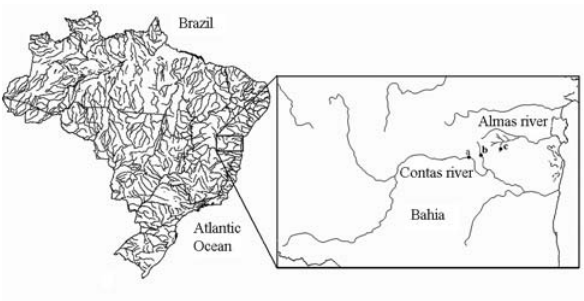
Figure 1 - Hydrographic map of Brazil showing in detail the main rivers for the Contas and Recôncavo Sul basins (State of Bahia) and collection sites of this study: (a) Contas River, (b) Preto do Costa River, and (c) Mineiro